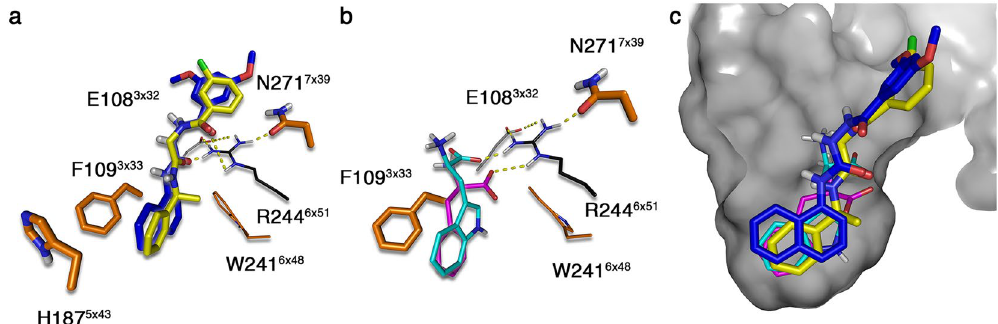
4 Scientific RepoRts | 7: 1128 | DOI:10.1038/s41598-017-01049-z